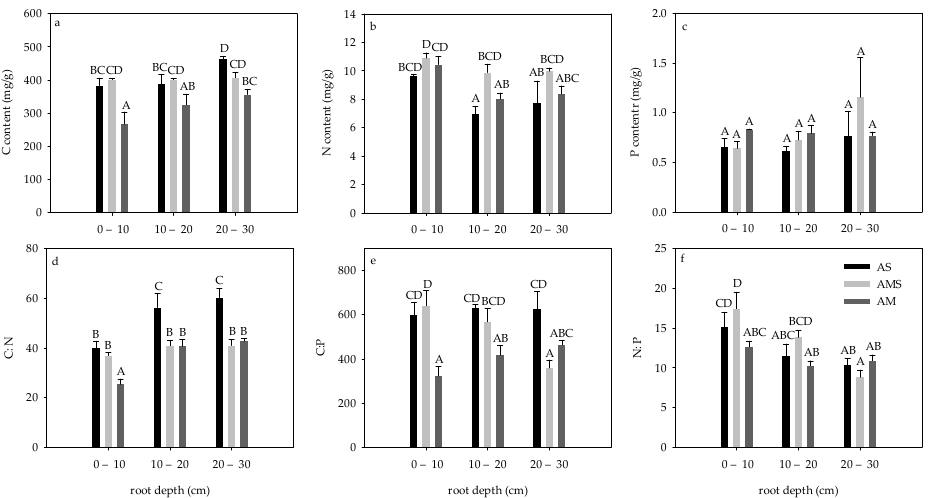
Figure 2. Root carbon, nitrogen, phosphorus, C: N, C: P, and N: P in August. ( a ) Root C content; ( b ) Root N content; ( c ) Root P content; ( d ) Root C: N; ( e ) Root C:P; ( f ) Root N:P. Root carbon content. Different letters correspond to statistical differences at 0.05 level.